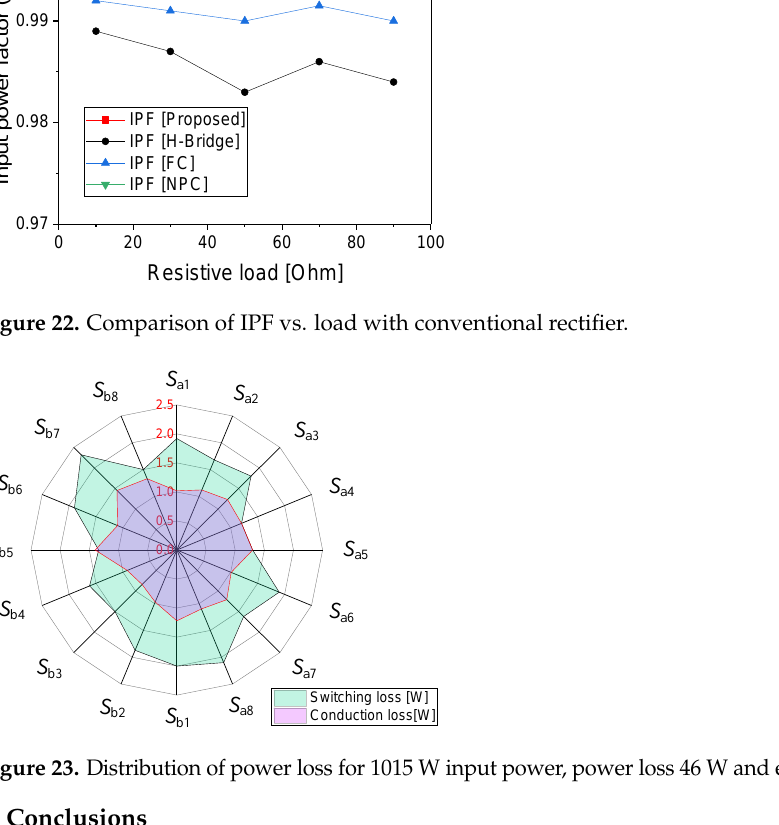
Figure 23. Distribution of power loss for 1015 W input power, power loss 46 W and efficiency is